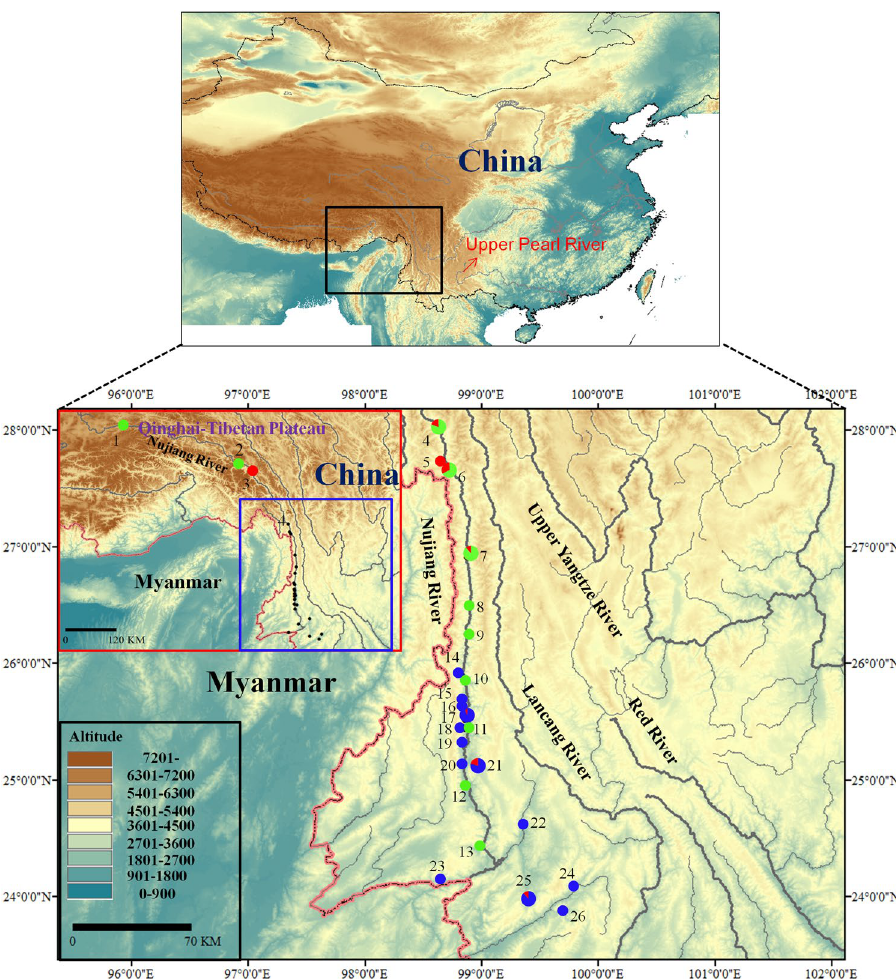
Figure 1. Map of the sampling sites for the Schizothorax species complex in the Nujiang River. The site numbers are presented in Table S1. 1–13, main stem sampling sites; 14–26, sampling sites for S . gongshanensis and S . lissolab1atus of the tributary in the Nujiang River. Populations are presented as pie-diagrams with slice-size proportional to the frequency of the three species (Red: S . gongshanensis ; blue: S . lissolab1atus ; and green: S . nukiangensis ). Sample sites harbored two species are exhibited with larger pie-diagrams. Map was created in the ArcGIS version 10.1 and modified in Microsoft